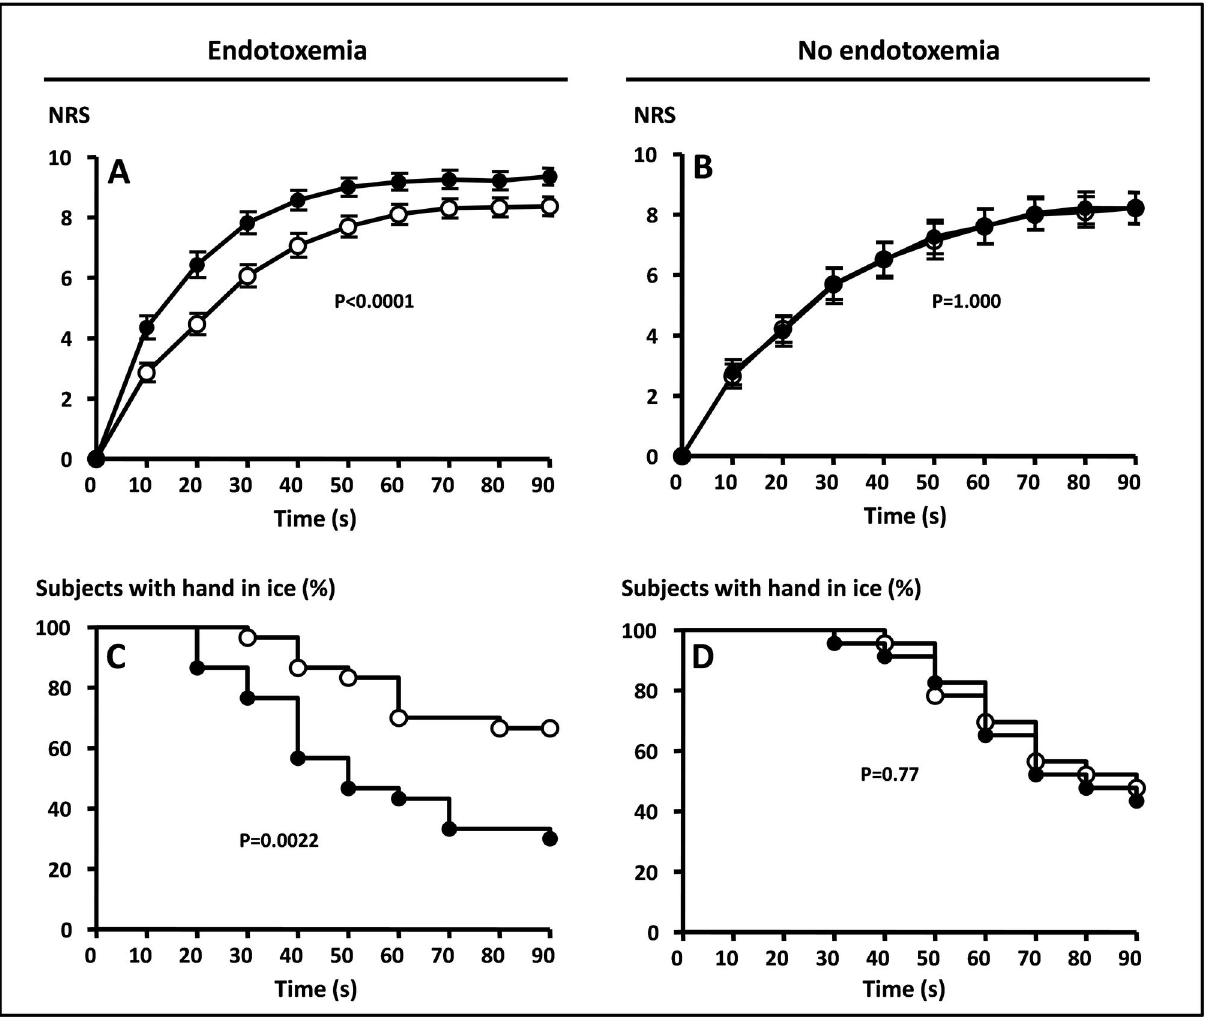
Figure 3. Change in tolerance to the cold pressor test during human endotoxemia. A and B: Amount of discomfort in response to immersion of one hand in ice water, rated on a 0-10 numeric rating scale (NRS). C and D: Percentage of subjects with hand in ice water. Open circles: . T=-1 hour (before endotoxin treatment), black dots: T=2 hours, (after endotoxin treatment). A and C: results in endotoxin treated group, B and D: results in control